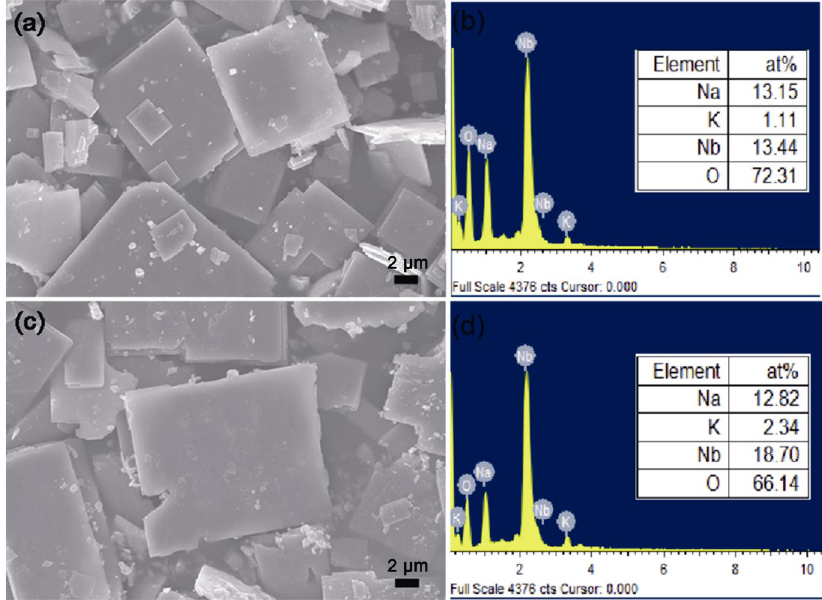
Fig. 5 SEM images of KNN platelets synthesized with KCl/NaCl ratios of (a) 2/1 and (c) 4/1; (b, d) EDS results corresponding to (a, c),